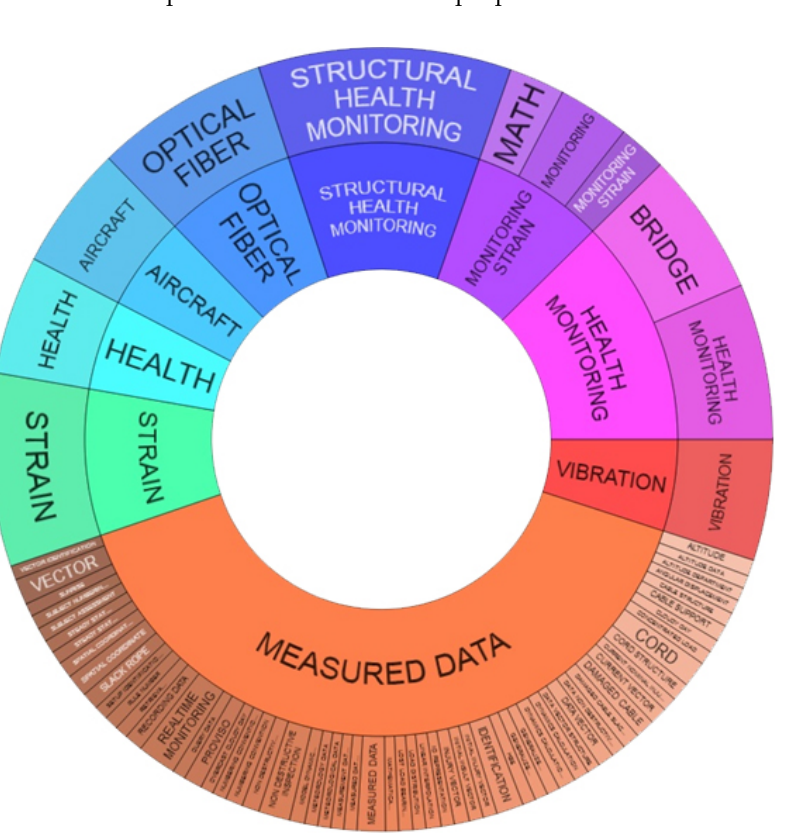
Figure 1. Patent data elaboration, University of L’Aquila,